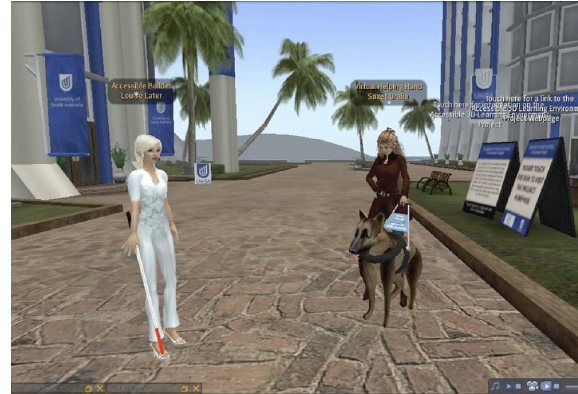
Figure 1. Participant recruitment in Second